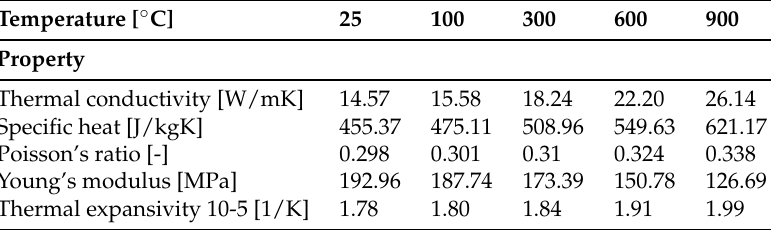
Table 2. Specimen 1 data after summation, inversion and smoothing.